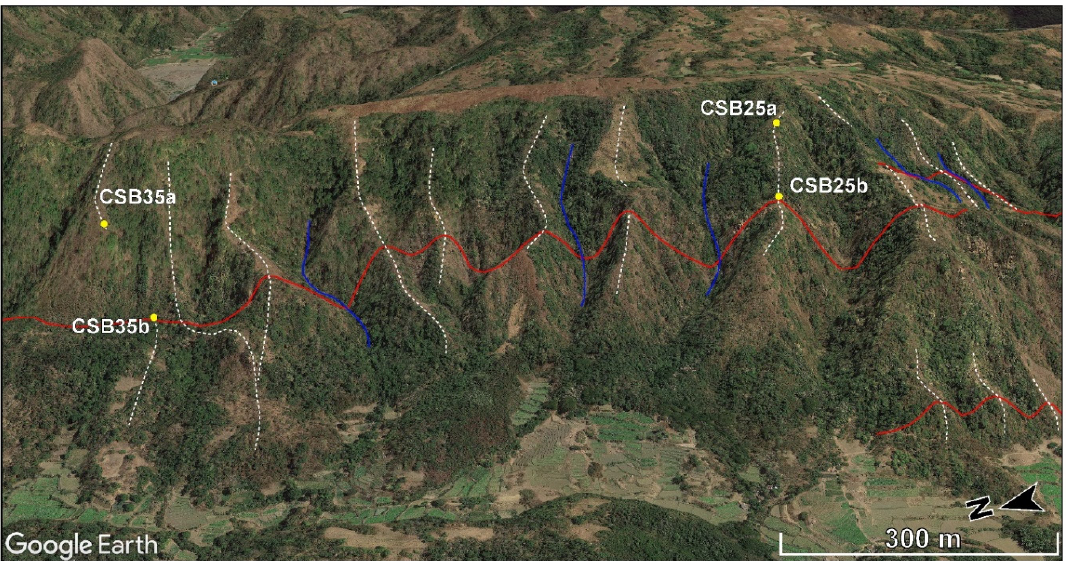
Figure 8. Google Earth perspective view of offset features along a stretch of the Vigan-Aggao Fault in the Badoc-Sinait area. This part of the fault is dominated by a horizontal component of slip. Location of this Google Earth perspective view is indicated by a black square in Figure 6.